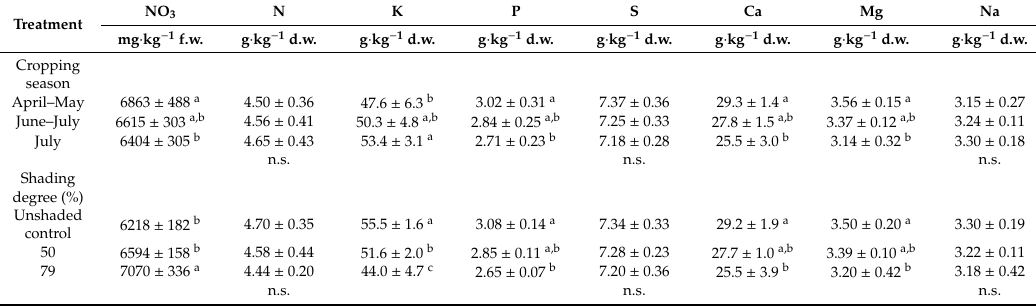
Table 3. Macroelement content in perennial wall rocket leaves as a ff ected by cropping season and shading